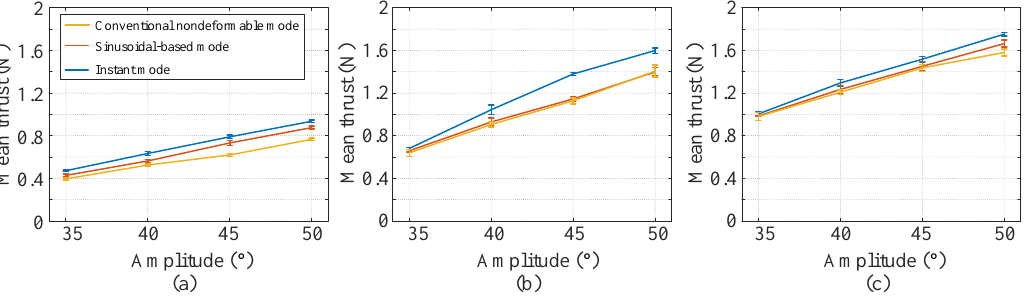
Figure 7. Comparison of mean thrust of the three deformation patterns: ( a ) Mean thrust at f = 0.20 Hz. ( b ) Mean thrust at f = 0.25 Hz. ( c ) Mean thrust at f = 0.30 Hz.